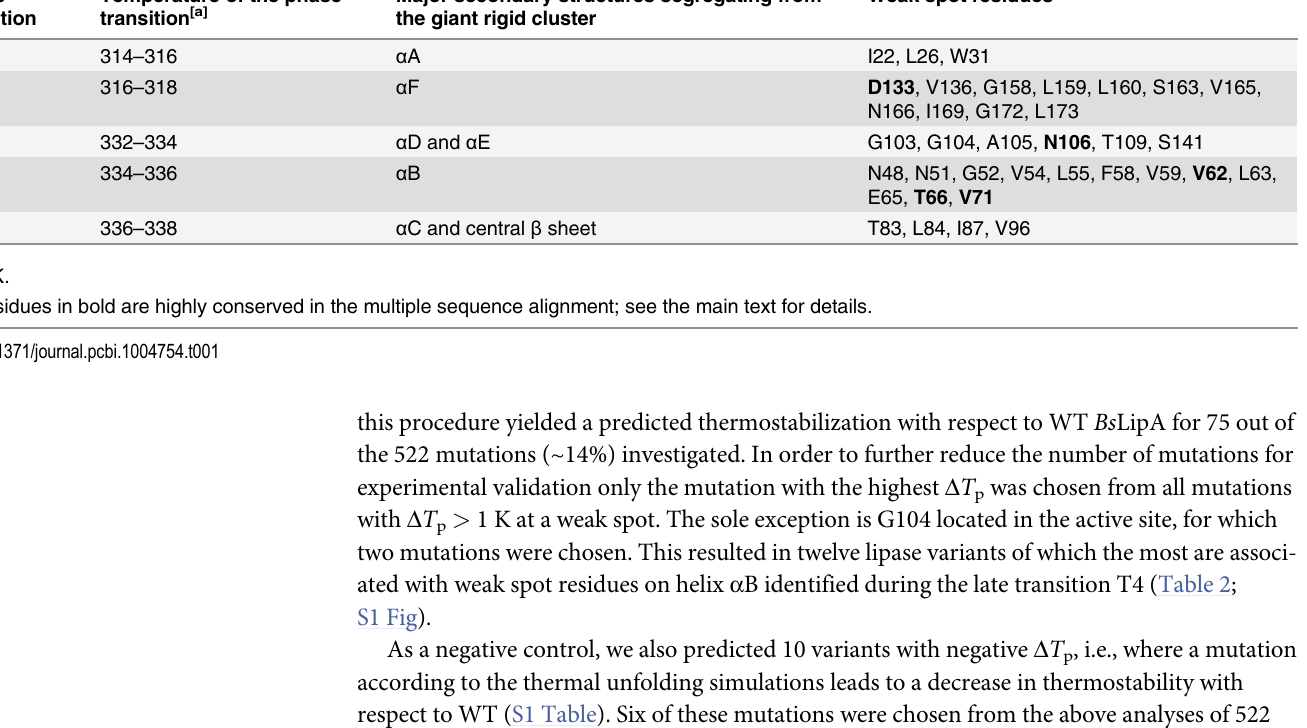
Table 1. Phase transition points at which weak spot residues are identified during the thermal unfolding simulation of Bs LipA. Phase transition